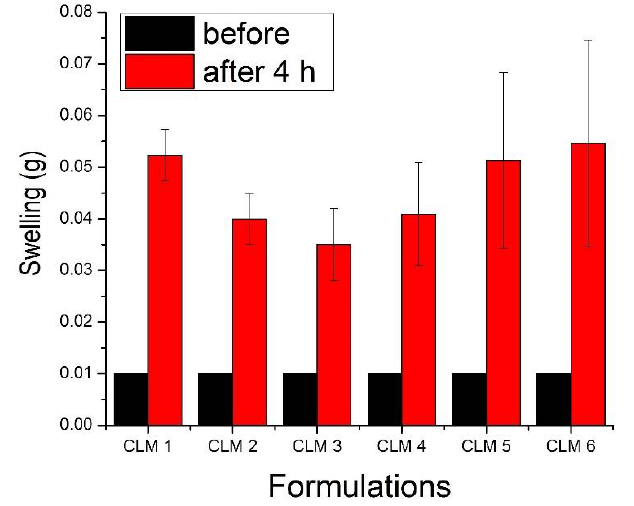
Figure 2. Swelling behavior of all formulations showing variation with respect to the concentration of oils. Error bars indicate standard deviation (n =